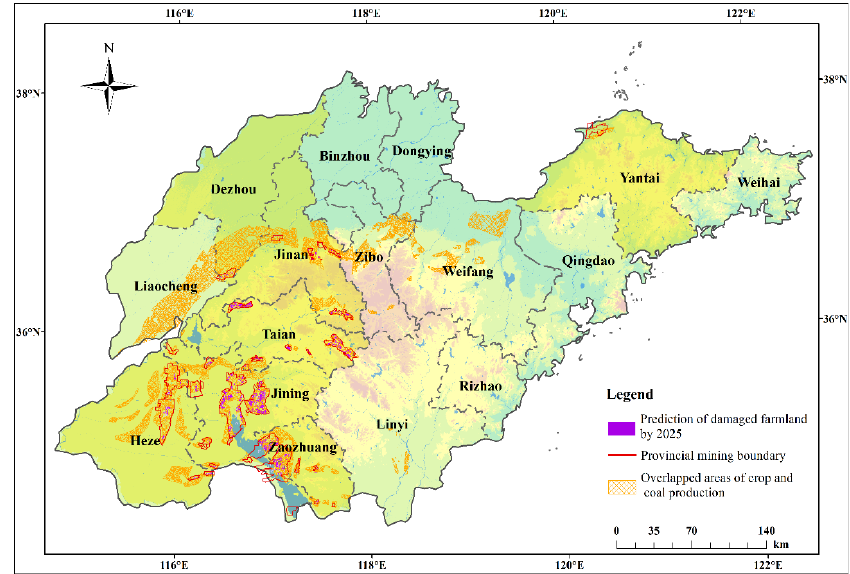
Figure 6. Prediction of damaged farmland area by 2025.